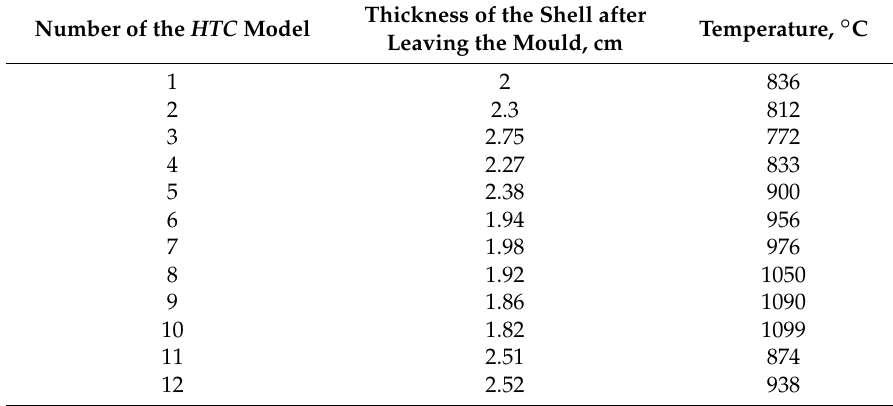
Table 2. Comparison of the shell thickness and temperature for those selected models of HTC (adopted from [6], with permission from Polish Academy of Science, 2018). Thickness of the Shell after Temperature, ◦ C Number of the HTC Model Leaving the Mould, cm 1 2